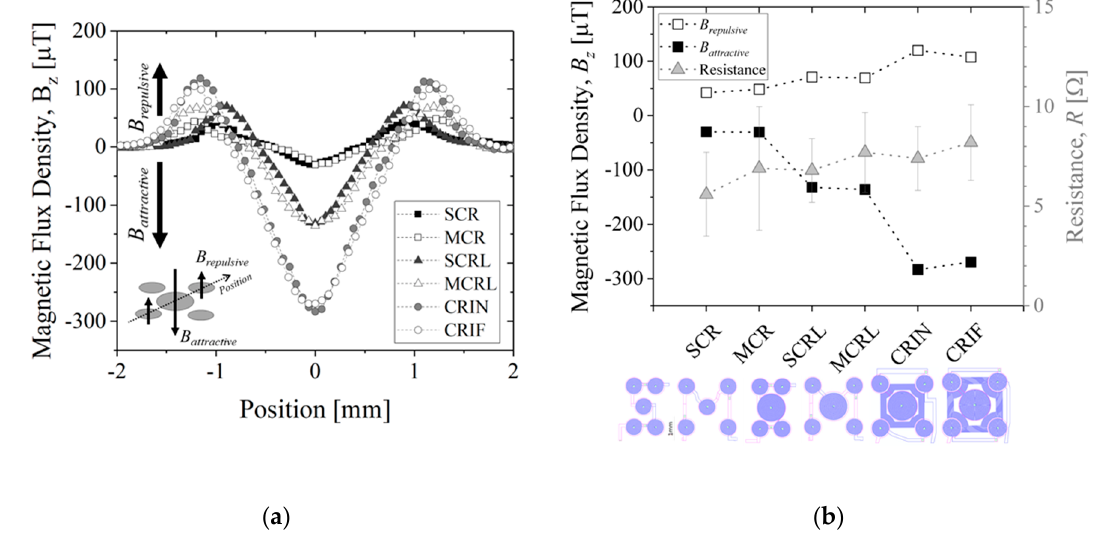
Figure 9. ( a ) MEMT magnetic response along the diagonal. When applying +30 mA current, the maximum of Bz is obtained in the external tracks ( B repulsive ) while the minimum ( B attractive ) is collected in the central coil and ( b ) magnetic flux density and corresponding resistance for each set of coils. Measurements performed at 200 µm from the chip surface.